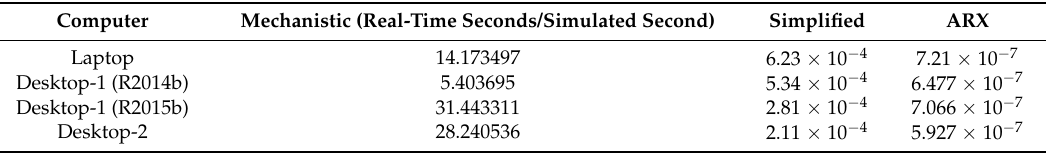
Table 3. Computer configurations.